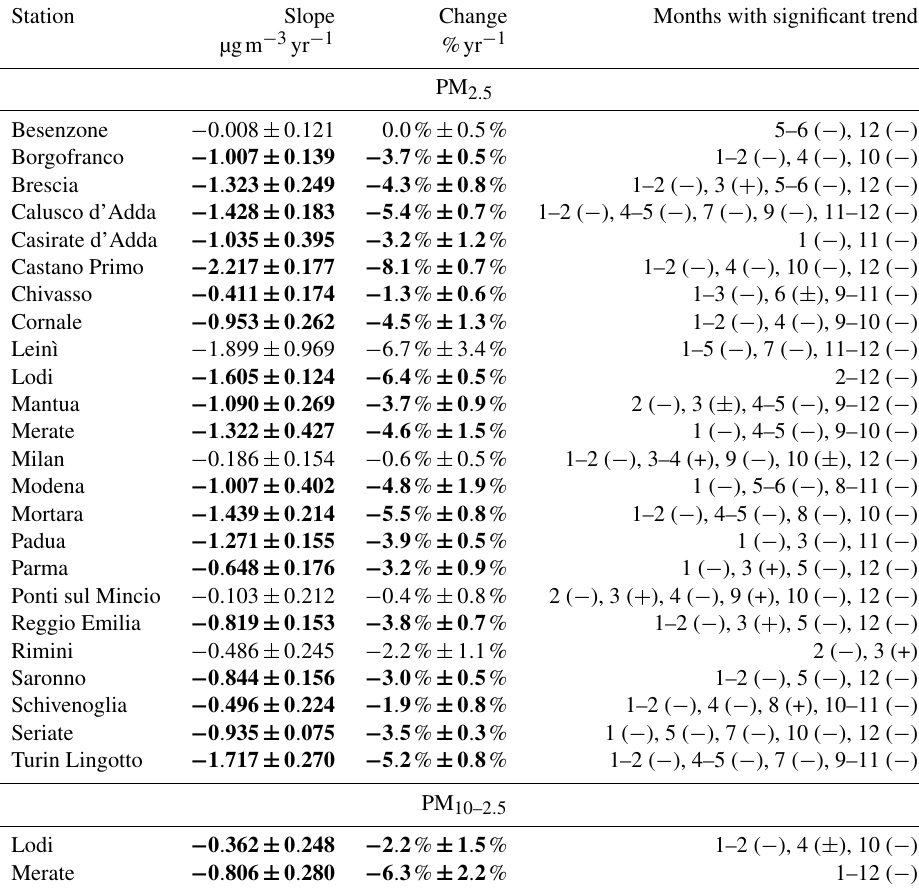
Table 2. Analysis of trend for monthly mean and for monthly frequency of PM 2 . 5 and PM 10–2 . 5 . Slope ( ± standard error) for monthly mean is computed by generalized least squares (GLS) on deseasonalized monthly mean time series of daily PM 2 . 5 or PM 10–2 . 5 concentration. Boldfaced values indicate slope significantly different from zero at a 95% confidence level. Variation in monthly frequency distribution was estimated by Theil–Sen